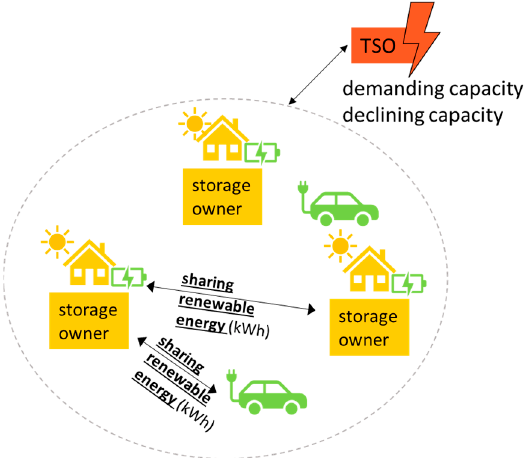
Figure 11. Community energy storage use-case. Dashed line denotes the community.